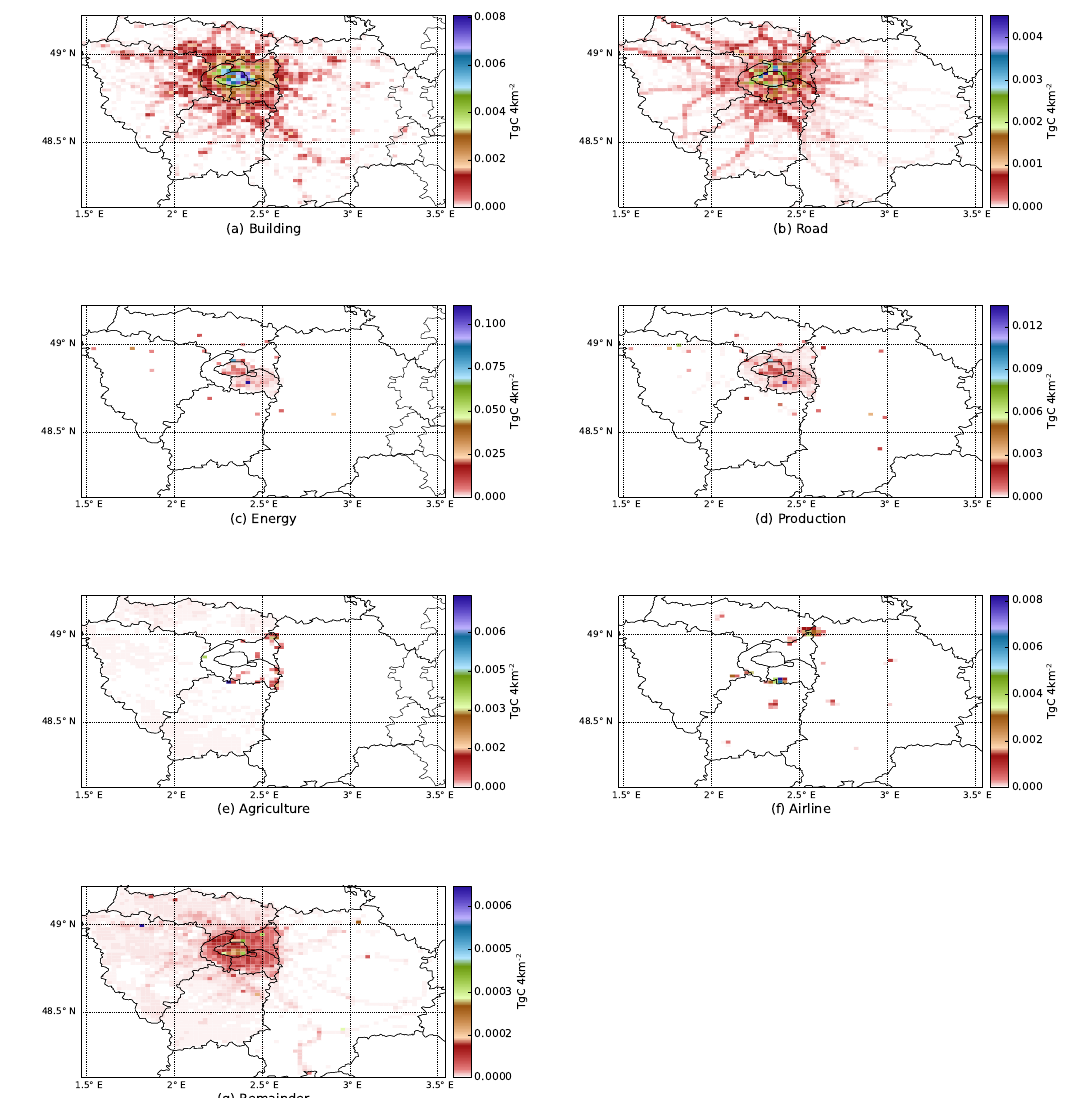
Figure 5. Sectoral and spatial distribution of the IER inventory over IDF for January